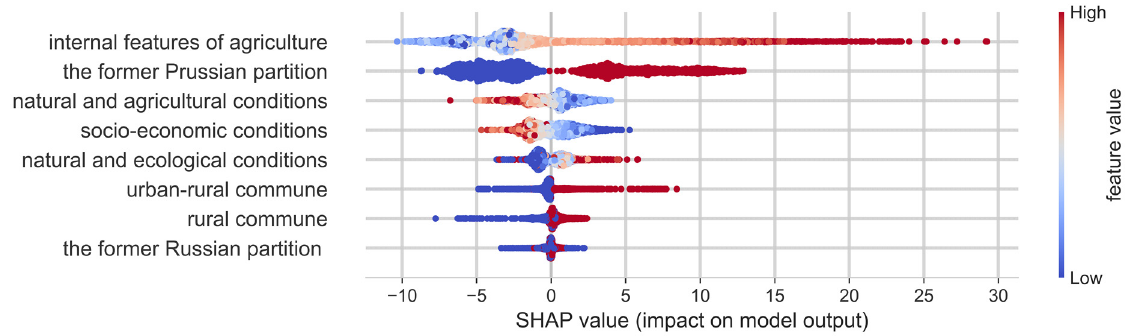
Figure 5. Values of SHAP parameter for particular determinants. Source: developed by the authors, based on ARMA and CSO data.